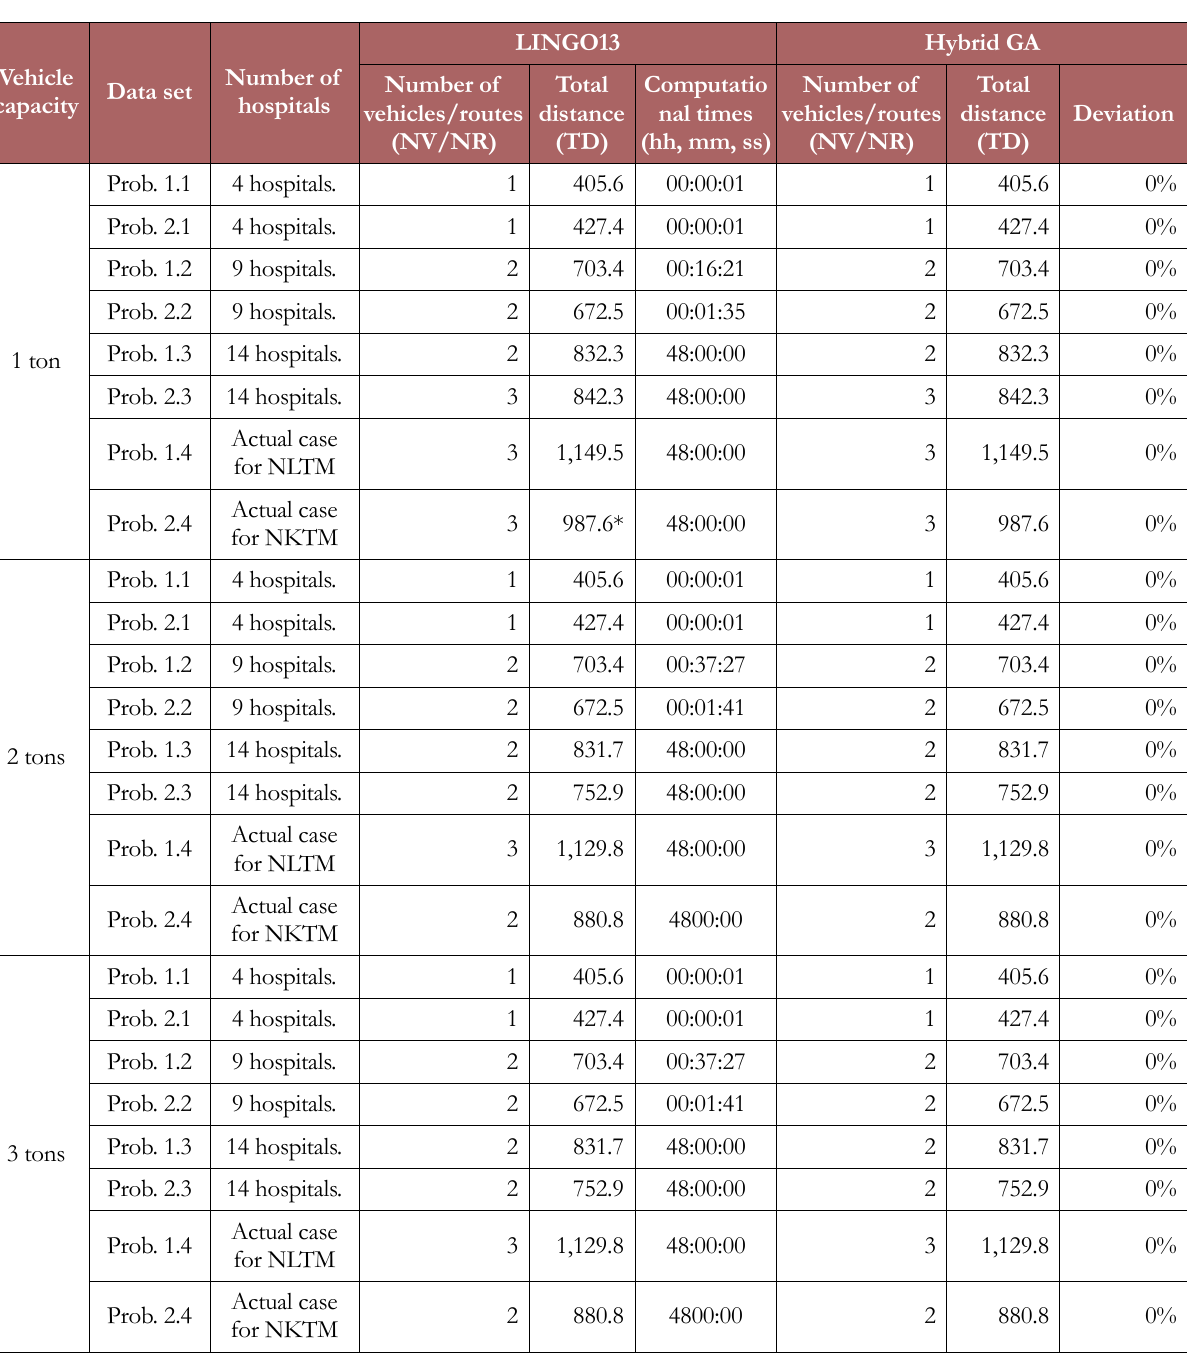
Table 10. Comparison of solutions using LINGO13 and hybrid GA